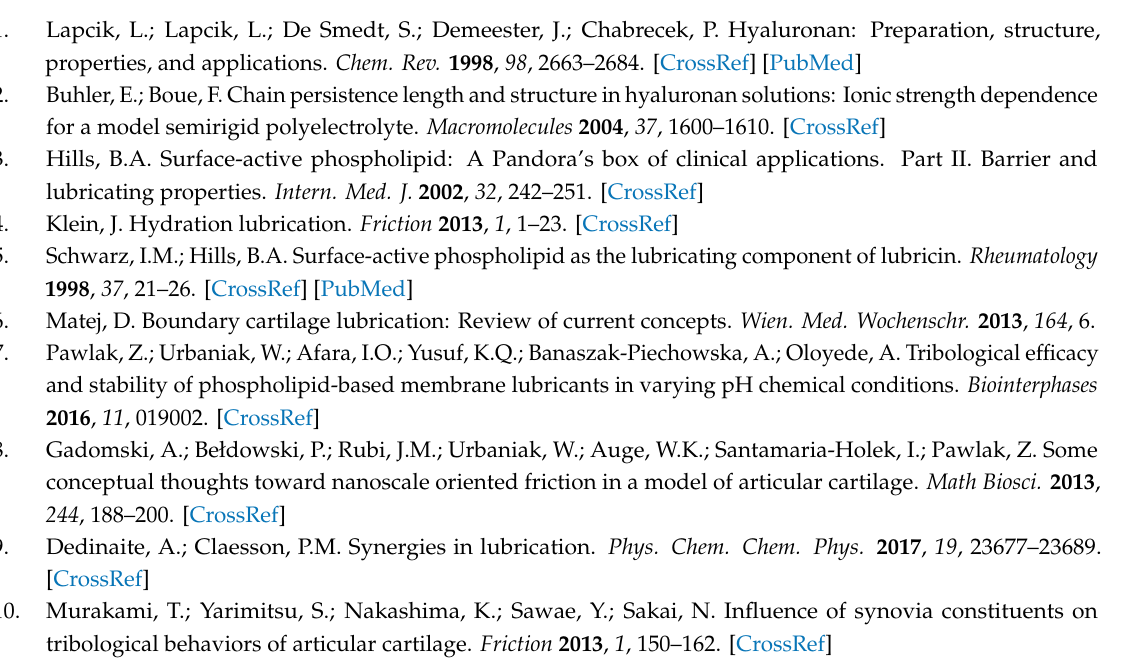
from the DSC measurements, Figure S2 DLS data of the vesicle-HA aggregates as function of the MW of HA. Figure S3 SAXS data of the vesicle-HA aggregates as function of the temperature. Figure S4 SAXS data of HA as function of the temperature. Table S1 Parameters of the fits of DPPC vesicles with and without HA in sodium chloride solutions. Table S2 Parameters of the fits of the DPPC vesicles and DPPC vesicles with and without HA in 150 mM NaCl with 10 mM CaCl 2